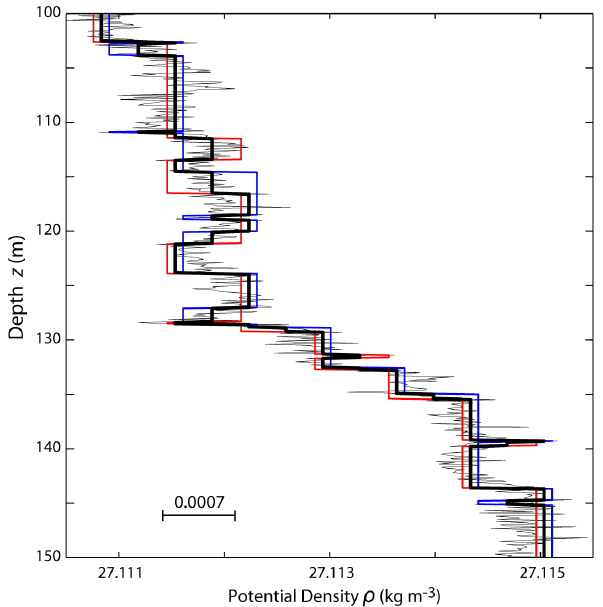
Figure 2. Sample section of intermediate profiles generated from the top (red), from the bottom (blue), and from the average of these two (thick black) of a measured density profile (thin black), follow- ing the method of Gargett and Garner (2008). The threshold density noise (0.0007kgm − 3 ) used is